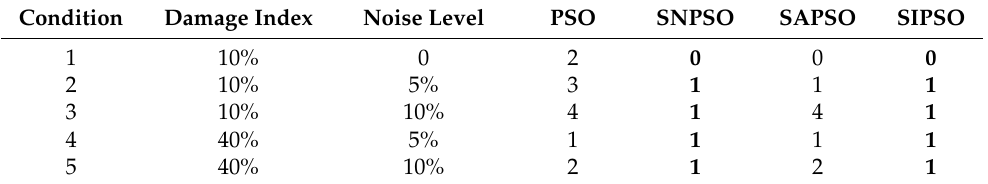
Table 5. Numbers of misjudgments in damage detection of four PSO-based algorithms with sin- gle damage.